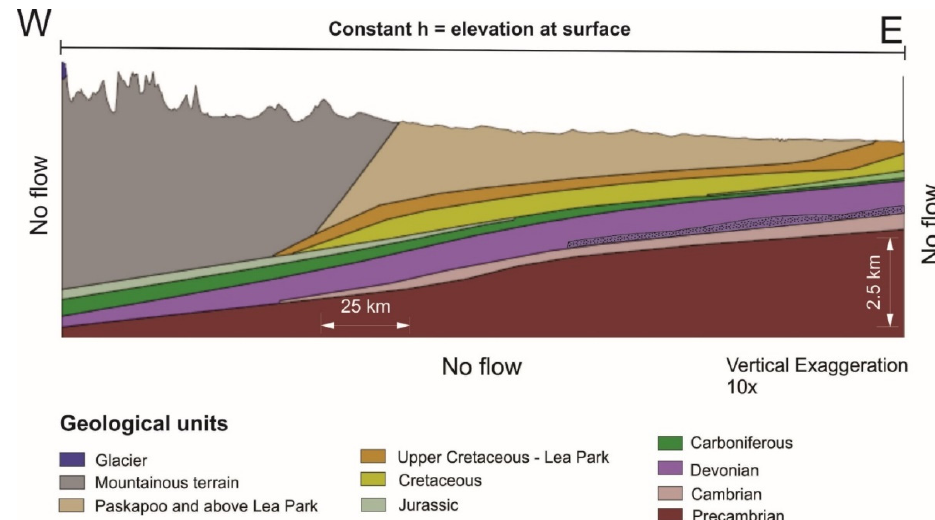
Figure 8. Boundary conditions for the steady-state flow simulations 1, 2 and 3.